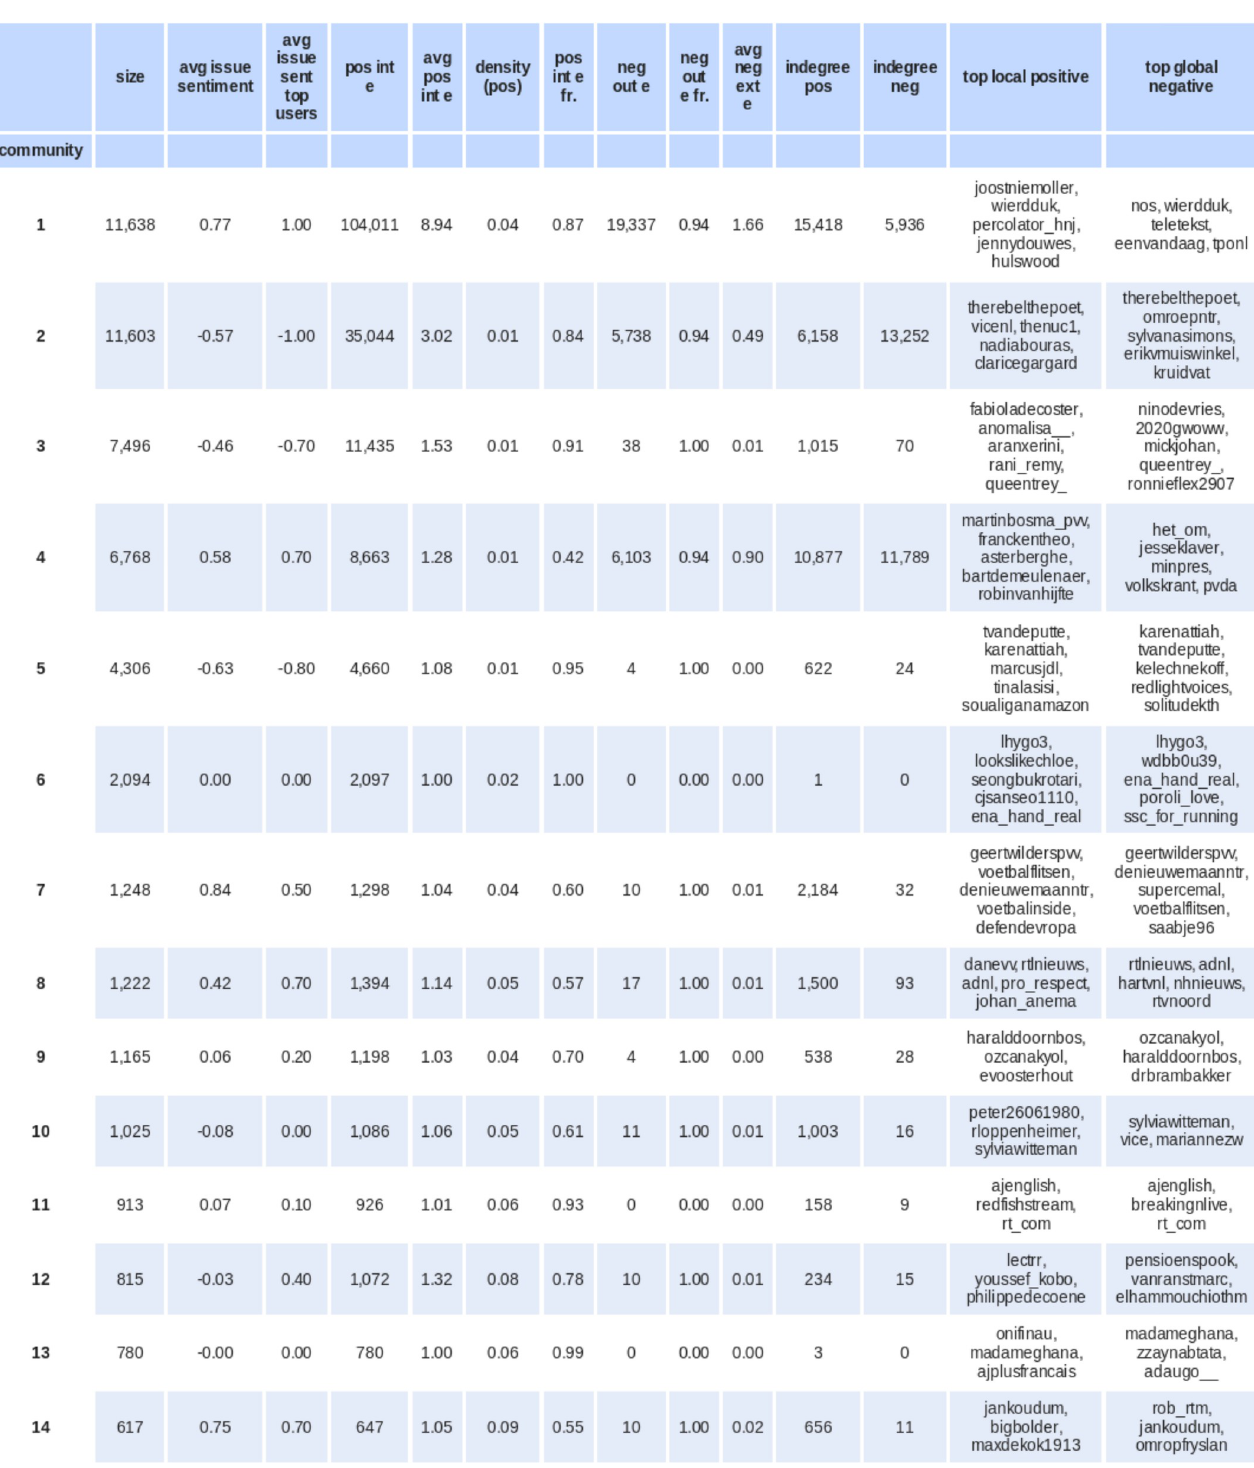
Fig 8. Community statistics signed network. Community statistics and their top users in the signed network (with size > 100). The average issue sentiment is calculated over the sentiment (pro-Black Pete = 1, anti-Black Pete = -1) of all users, and reported separately for the top 10 users most often positively related to from within the community. Column ’pos int e fraction’ divides the positive edges within the community by the total positive edges outgoing from community members and ’neg out e fr.’ divides negative edges within the community by the total negative edges outgoing from community members. The columns ’avg pos int e’ and ’density (pos)’ divide the total positive edges by the number of users and the possible edges in the community, respectively. The column ’top global negative’ lists the users in this community that are most frequently negatively mentioned by other communities. https://doi.org/10.1371/journal.pone.0256696.g008 PLOS ONE | https://doi.org/10.1371/journal.pone.0256696 August 31,